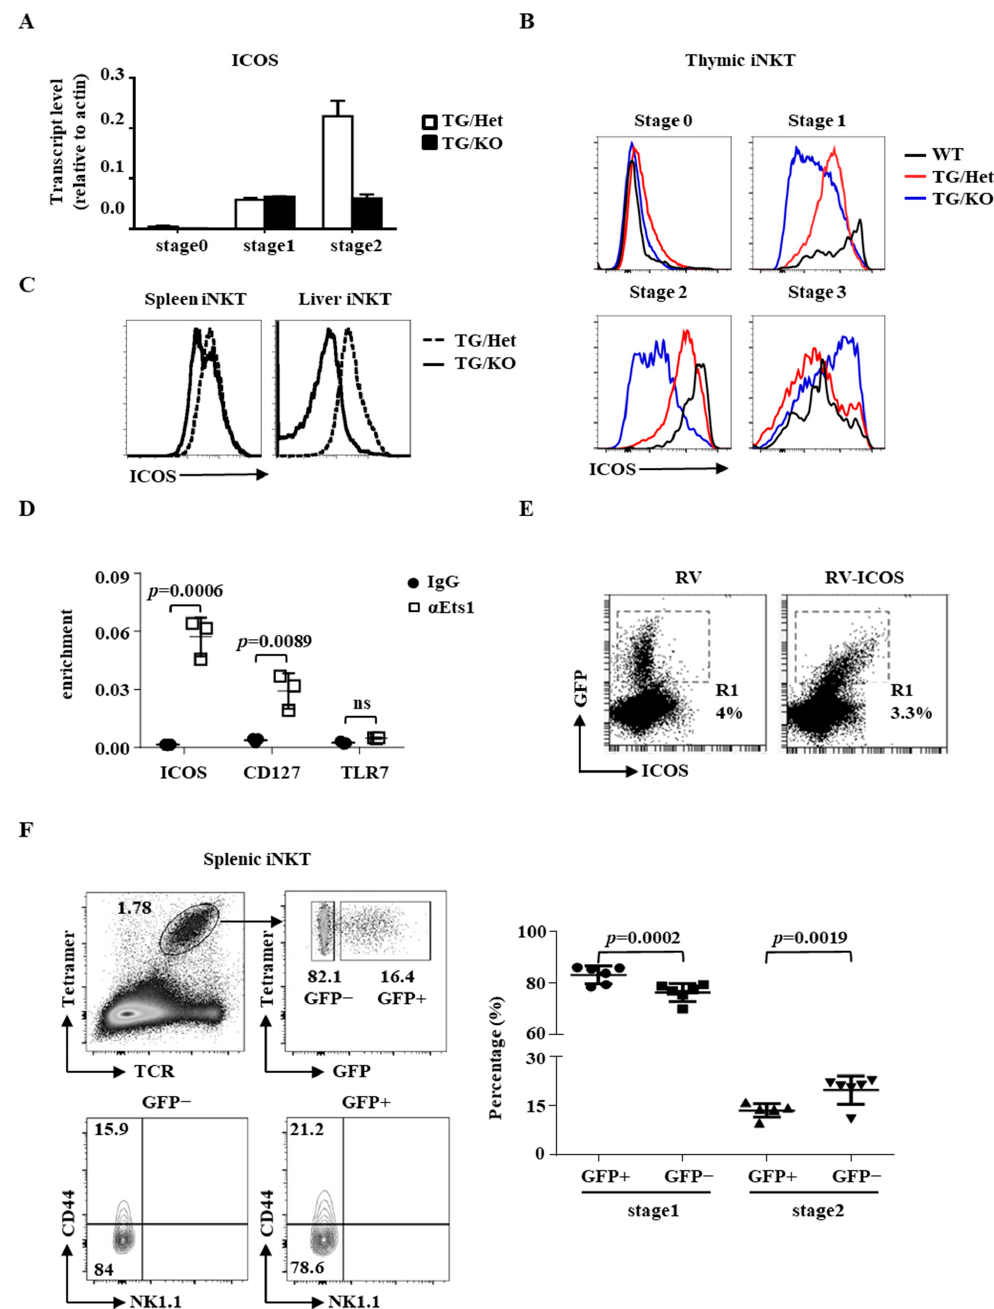
Figure 5. Identification of ICOS as a target gene of Ets1. ( A ) cDNA was prepared from various thymic iNKT subpopulations of indicated genotypes, and the transcript levels of ICOS were quantified with quantitative PCR. ( B , C ) The surface levels of ICOS in different stages of thymic iNKT cells ( B ) and peripheral iNKT cells ( C ) are shown. ( D ) Activated Th cells were subjected to ChIP analysis using anti-Ets1 or control IgG. The recruitment of Ets1 to the promoter of ICOS, CD127, and TLR7 was examined with quantitative PCR. ( E , F ). Bone marrow cells transduced with RV vector alone (RV) or GFP − ICOS-RV (RV-ICOS) and stained with ICOS. The co-expression of ICOS and GFP are shown in ( E ). Splenic iNKT cells of WT mice reconstituted with GFP − ICOS retrovirus-transduced TG/KO bone marrow cells were identified with TCR/CD1d-tetramer (the upper panel of ( F )) and divided into GFP+ (transduced) and GFP − (un-transduced) populations (the upper panels of ( F )). The distribution of stage 1, 2, and 3 GFP+ and GFP − donor iNKT cells was determined by NK1.1 and CD44. Representative FACS plots are shown in the bottom panels of ( F ). Cumulative data from six mice are shown in the right panel of ( F ). Statistical analyses were performed with a paired Student’s t